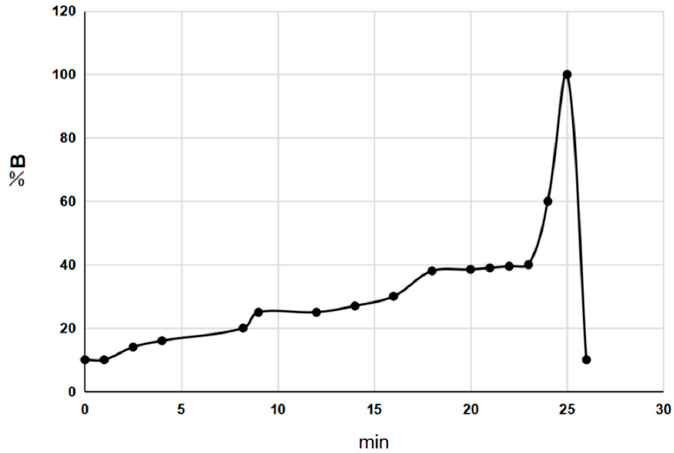
Figure 7. The gradient program of solvent B.